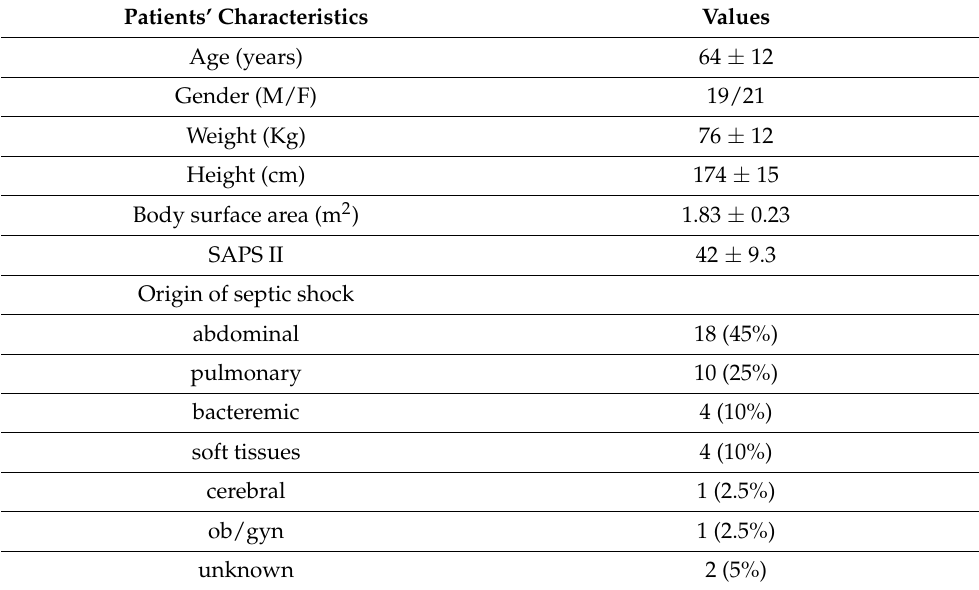
Table 1. Patients characteristics. Data are expressed as percentage and mean ± standard